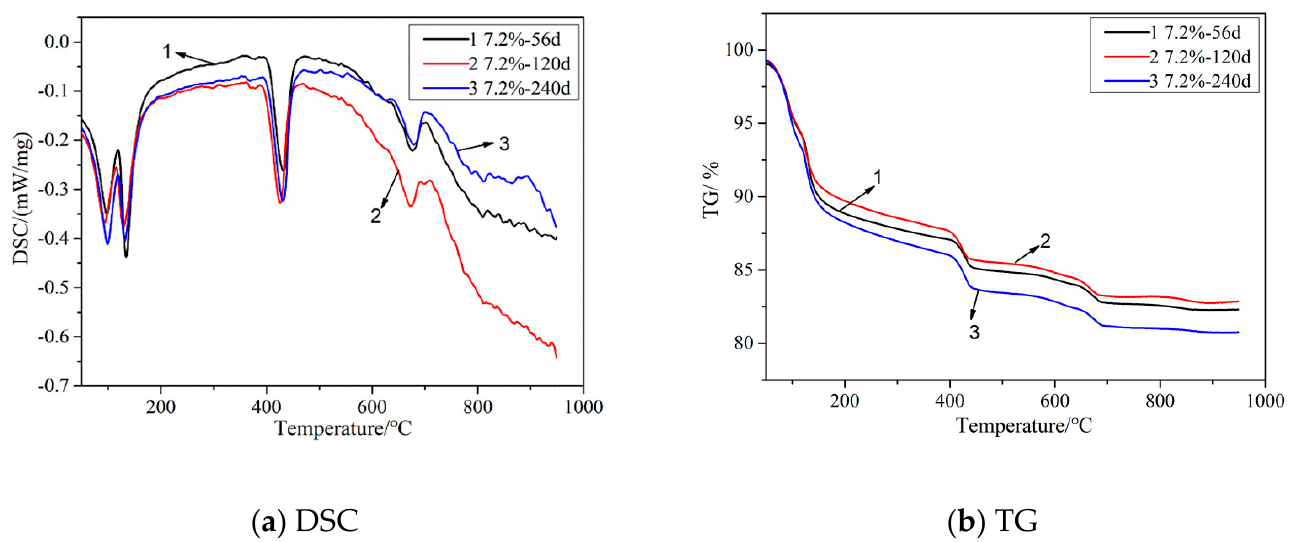
Figure 8. TG–DSC curves of cement pastes added with 7.2% SO 3.